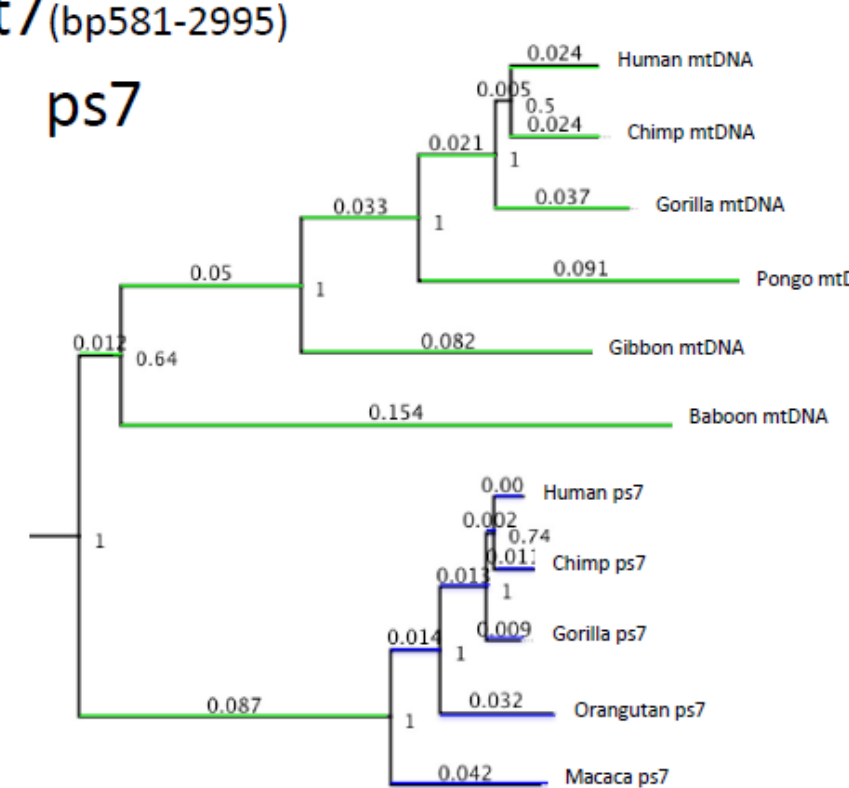
Figure 4. Phylogenetics of the pseudogene Ps7 and old-world monkey mtDNA.